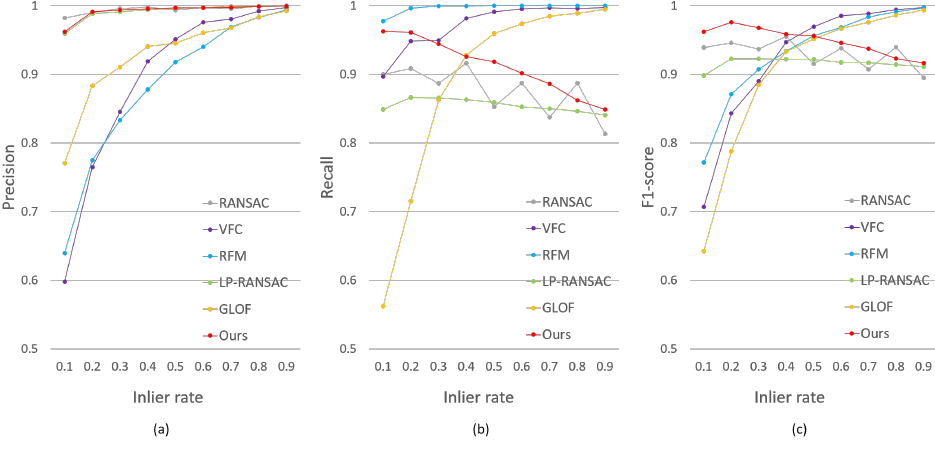
Figure 6. Matching accuracy performance comparison of the considered six methods for the “Airport” dataset. ( a ) For precision. ( b ) For recall. ( c ) For F1-score.